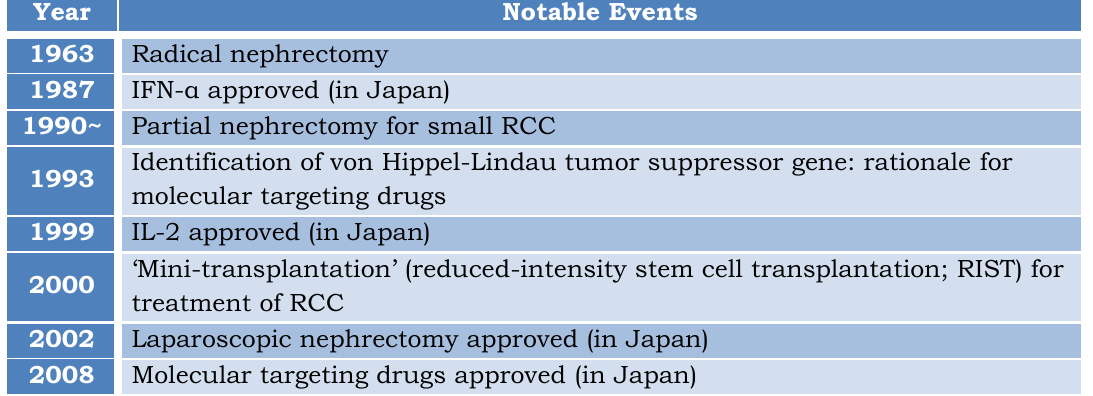
Table 1. History of therapy for renal cell carcinoma (Revised from